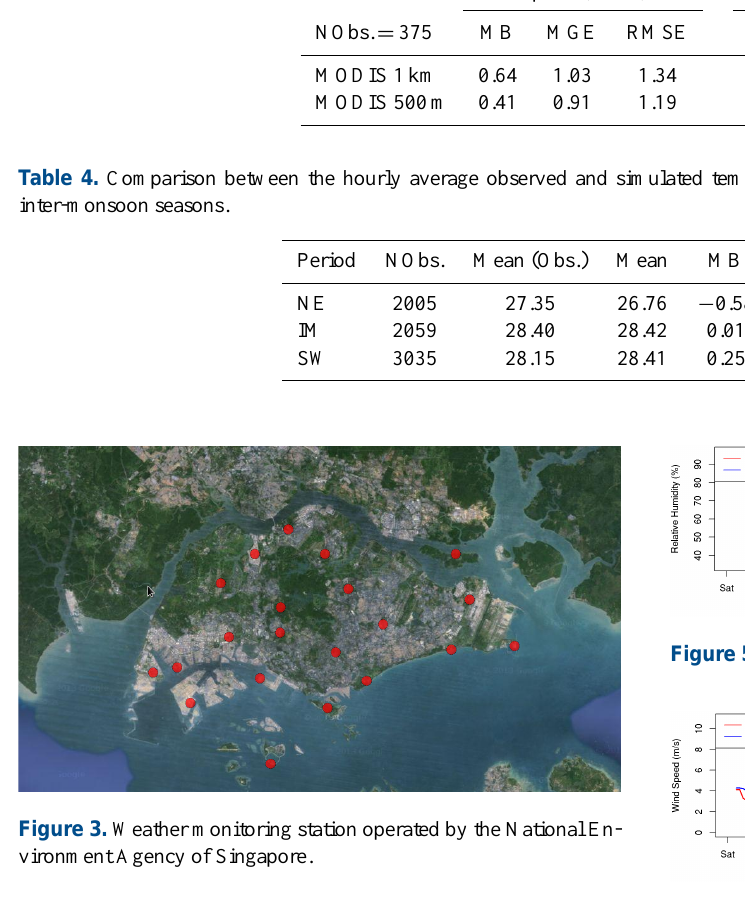
Figure 6. Same as Fig. 4 but for wind